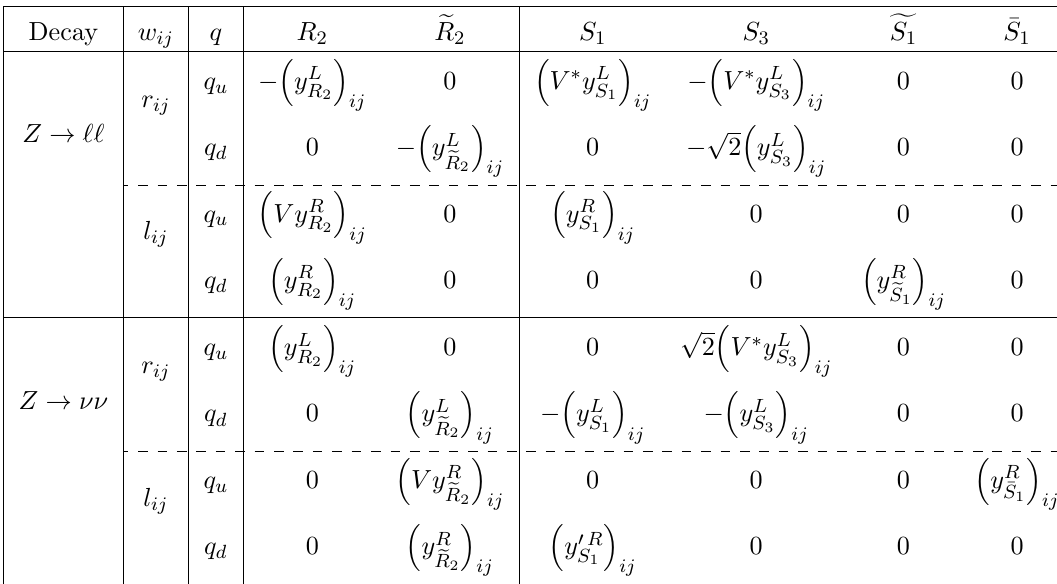
Table 1 . Expressions for the coe(cid:14)cients w ij in eq. (3.12) and (3.13) obtained by the matching of eq. (3.9) and (3.10) onto the Yukawa Lagrangians listed in section 2 for LQs with fermion number F = 0 and F = 2, j j